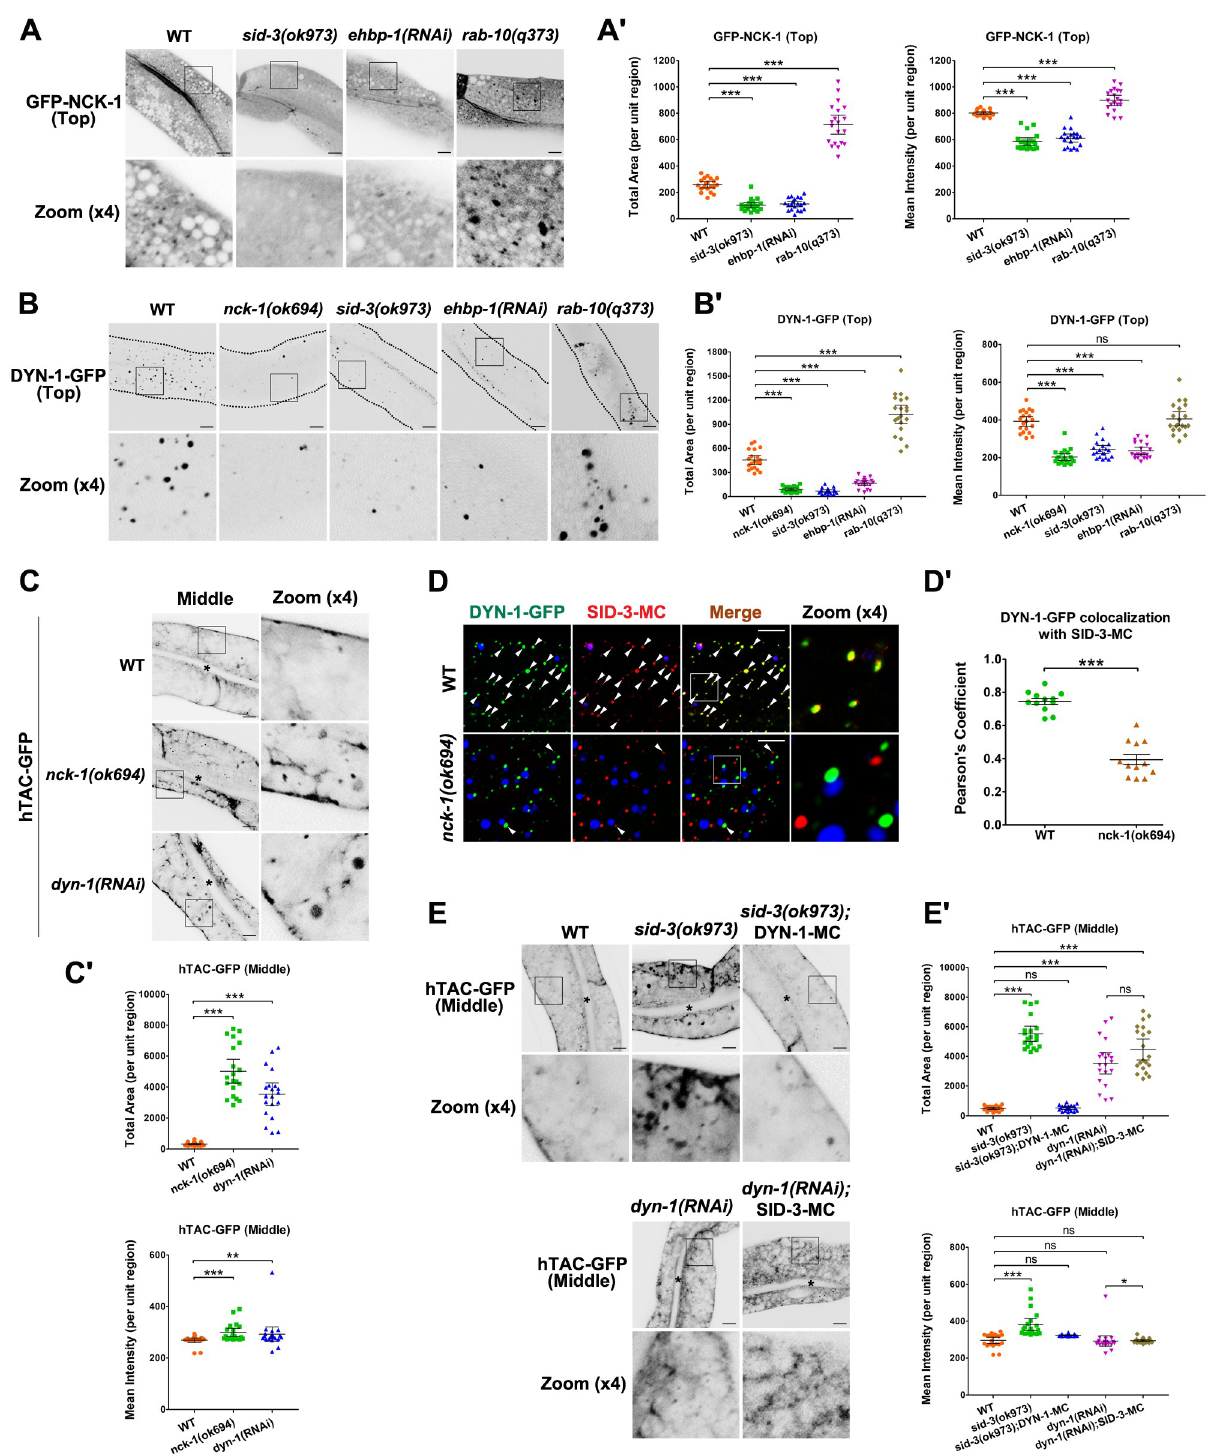
Fig 4. EHBP-1 sequentially recruits SID-3, NCK-1, and DYN-1. ( A-A 0 ) Confocal images of the worm intestinal cells expressing GFP-NCK-1. In the top focal plane, GFP-NCK-1 labeled punctate structures. In sid-3(ok973) or ehbp-1(RNAi) animals, GFP-NCK-1 labeled structures significantly diminished. Instead, GFP-NCK-1 overaccumultaed in punctate structures in rab-10(q373) intestinal cells. ( B-B 0 ) Confocal images showing DYN-1-GFP subcellular distribution. DYN-1-GFP labeling on intestinal puncta was reduced in nck-1(ok694) , sid-3(ok973) , and ehbp-1(RNAi) intestinal cells. Conversely, DYN-1-GFP overaccumultaed in enlarged structures in rab-10(q373) intestinal cells. Boundaries of intestines are outlined by dashed lines.